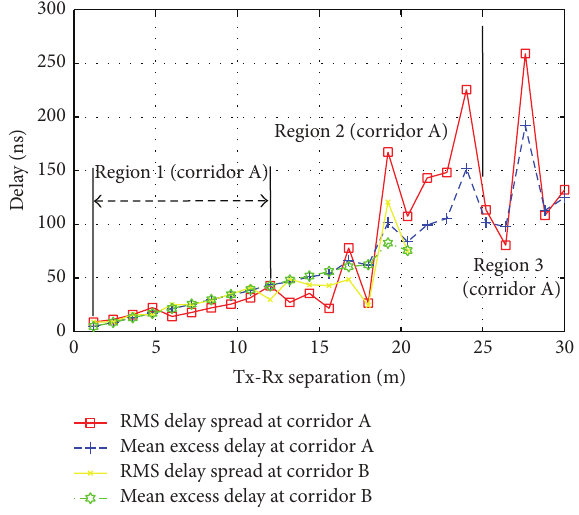
Figure 8: RMS delay spread versus link